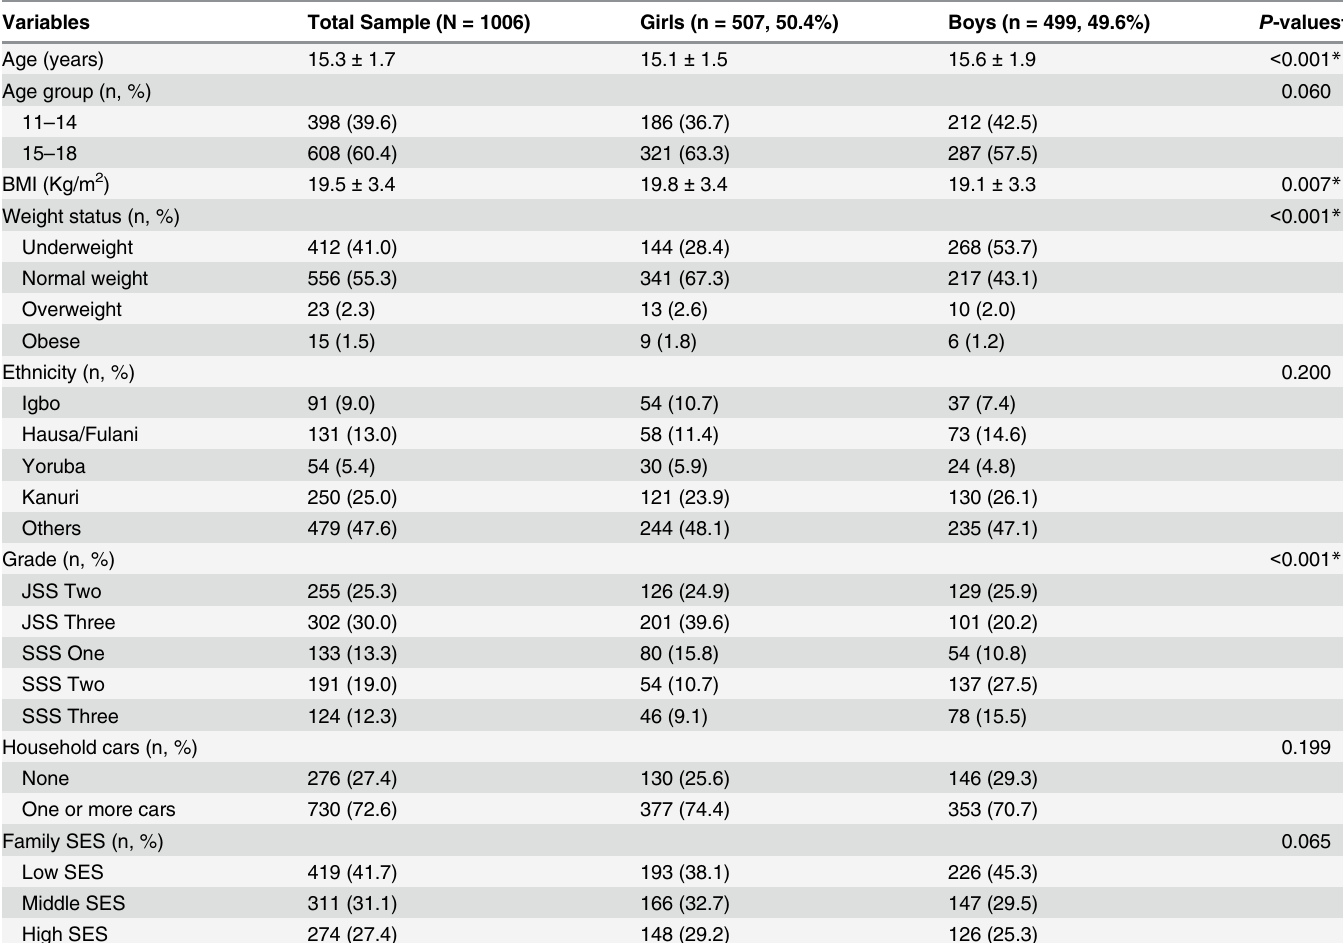
Table 1. Descriptive characteristics of the